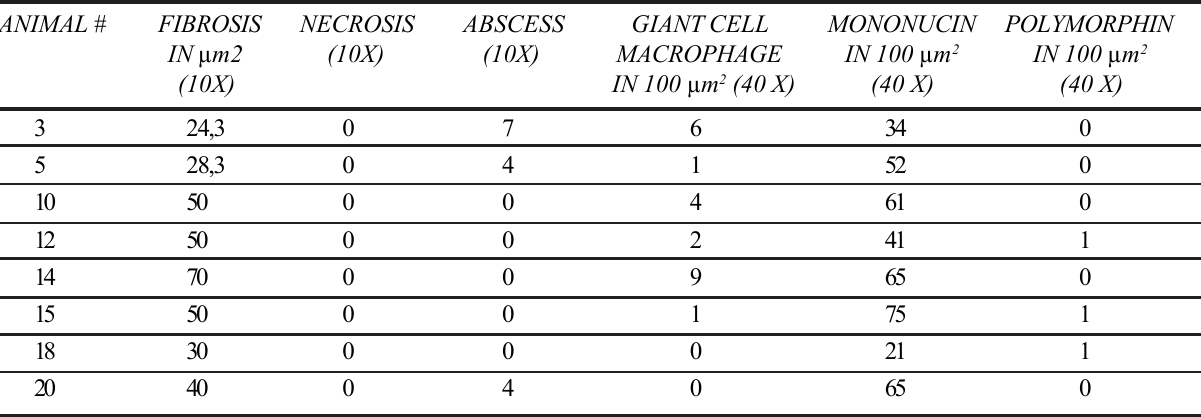
TABLE 4 - Mean of measurement and counting of microscopic finding of three cuts, in each animal of cohort E-A, under